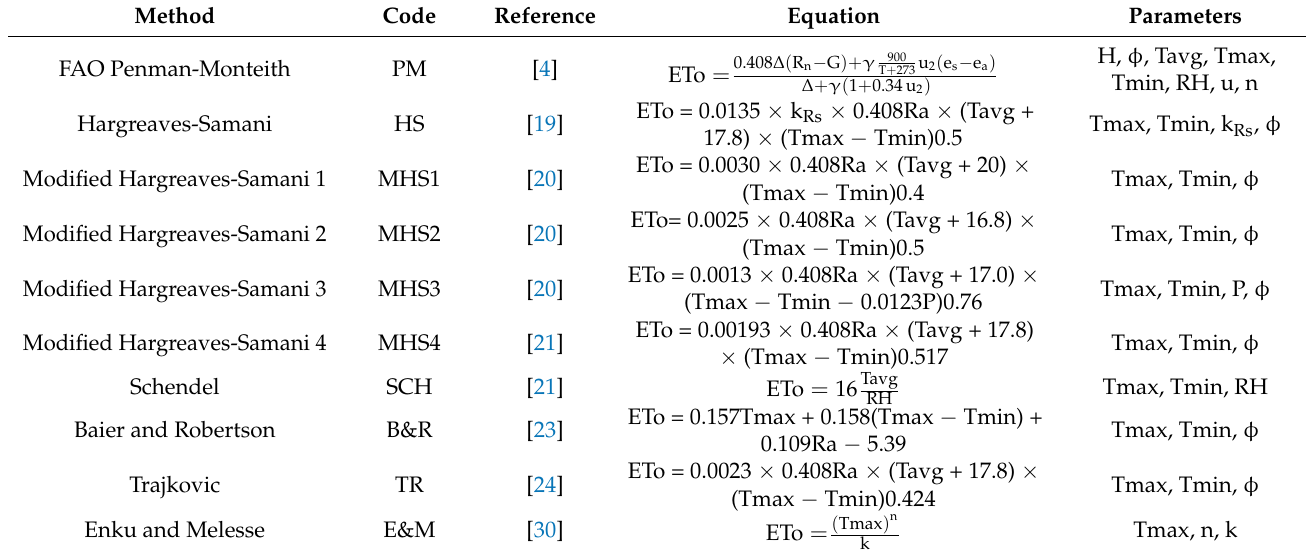
Table 3. Method used and the parameters applied in each